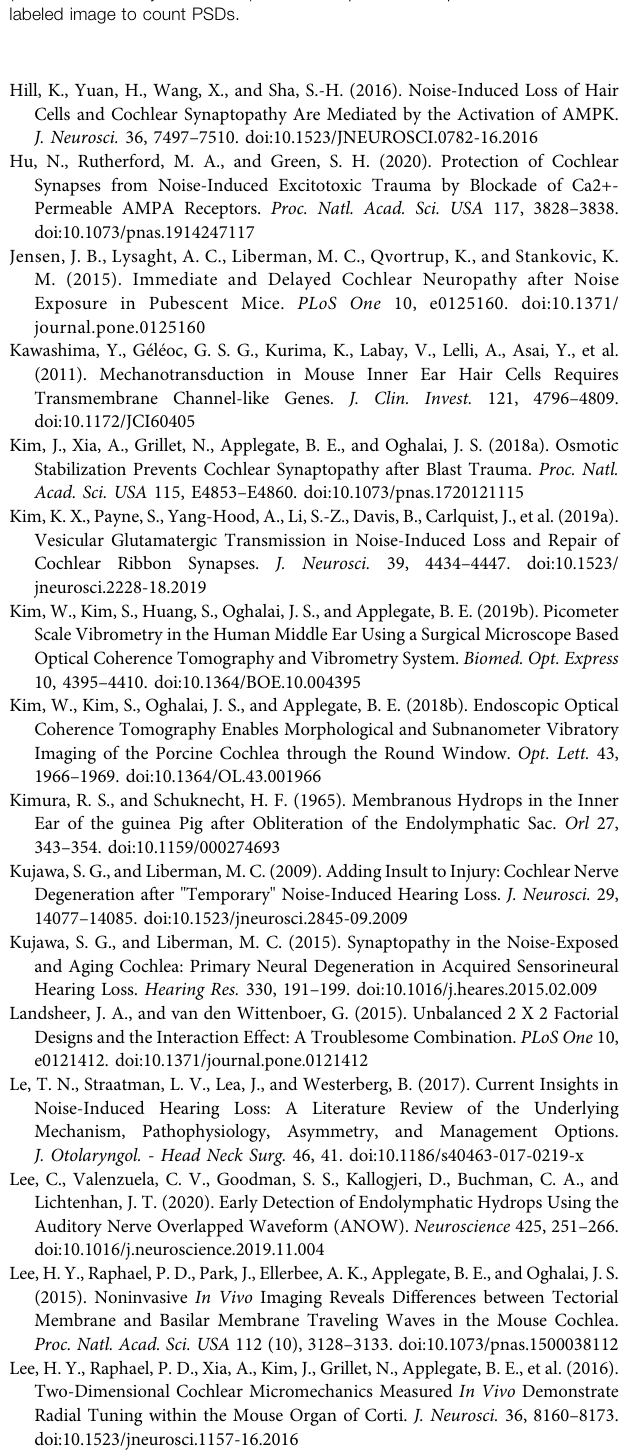
corner. (B) From the CtBP2-labeled image, a2D median fi lter of ± 1.4 μ m removes most of the smaller features of the image and just leaves the background. (C) A median fi lter of ± 0.35 μ m is used to smooth out the original data and reduce speckle noise. (D) Structures the size of ribbons are isolated by subtracting (B) from (C) . (F) Ribbons are identi fi ed by selecting only those structures with an intensity above a set threshold and with a height in the z-direction > 0.48 μ m (ribbons marked by blue circles). This same process is repeated for the Homer- labeled image to count